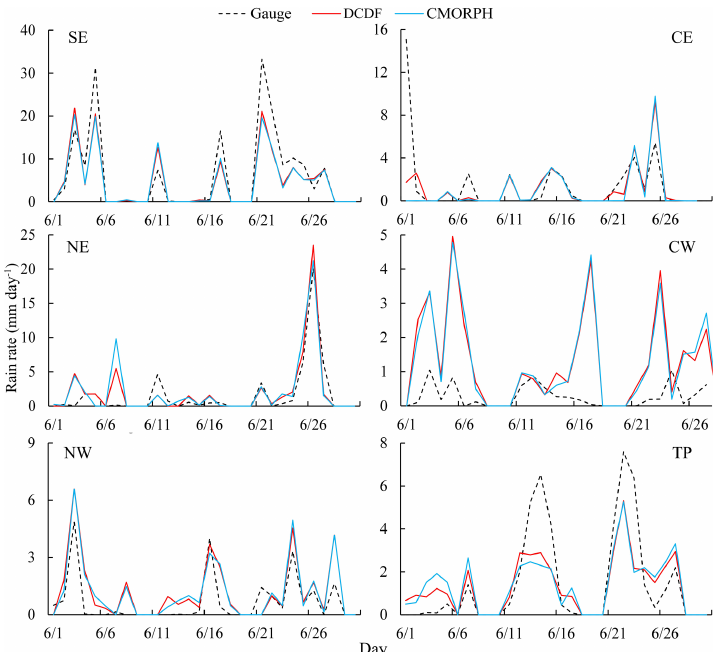
Figure 7. Time series of the average precipitation of each region derived from the gauge, DCDF and CMORPH at the daily scale in June